Question: Write a descriptive caption for this figure.
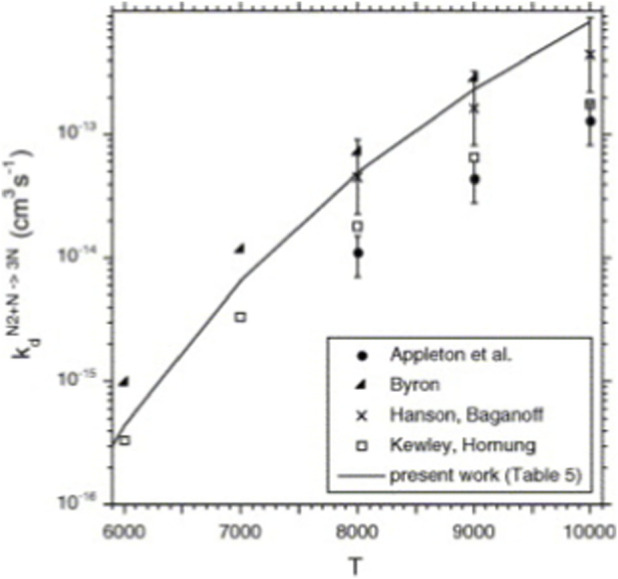
Answer: Experimental measurements (points) and Esposito work ( Esposito et al., 2006 ) (line) global dissociation rate coefficients versus T for the process N 2 +N→3N.